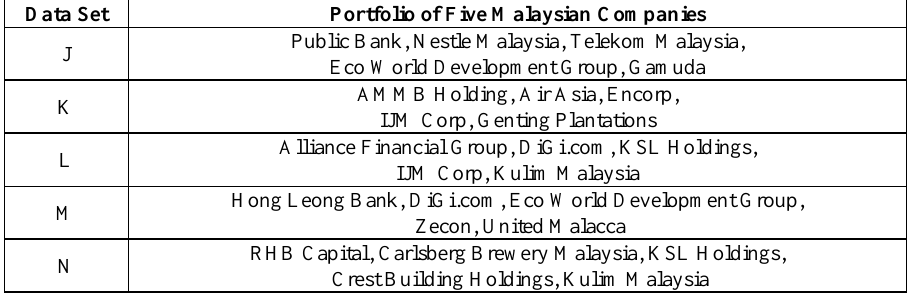
Table 1. List of Malaysian companies in data sets J, K, L, M and N. Data